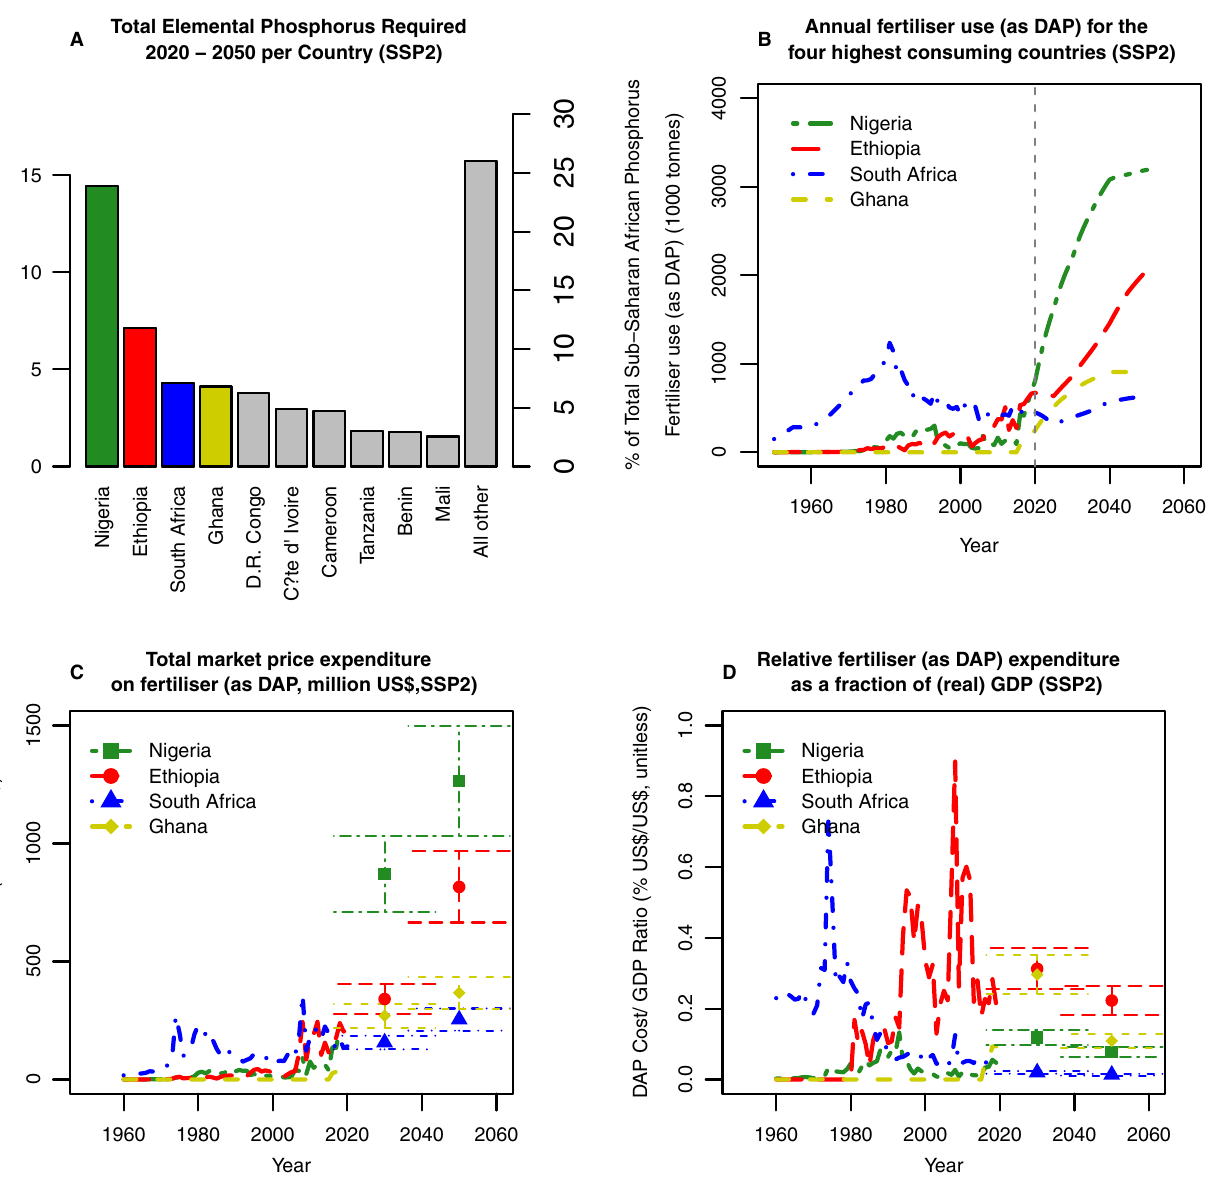
Fig. 4 | Trajectory of phosphorus requirement and associated estimated costs in different Sub-Saharan African countries. For SSP2 ( A ) Total phosphorus required (million tonnes) and percentage breakdown for Sub-Saharan Africa between 2020 and 2050; B Historic and projected DAP use (1000 tonnes) 1950 – 2050 in Nigeria, Ethiopia, South Africa and Ghana; and C historic and pro- jected DAP costs (million US$) 1950 – 2050 in Nigeria, Ethiopia, South Africa and Ghana;and D historicand projectedfertiliserexpenditure(as DAP)relative to GDP